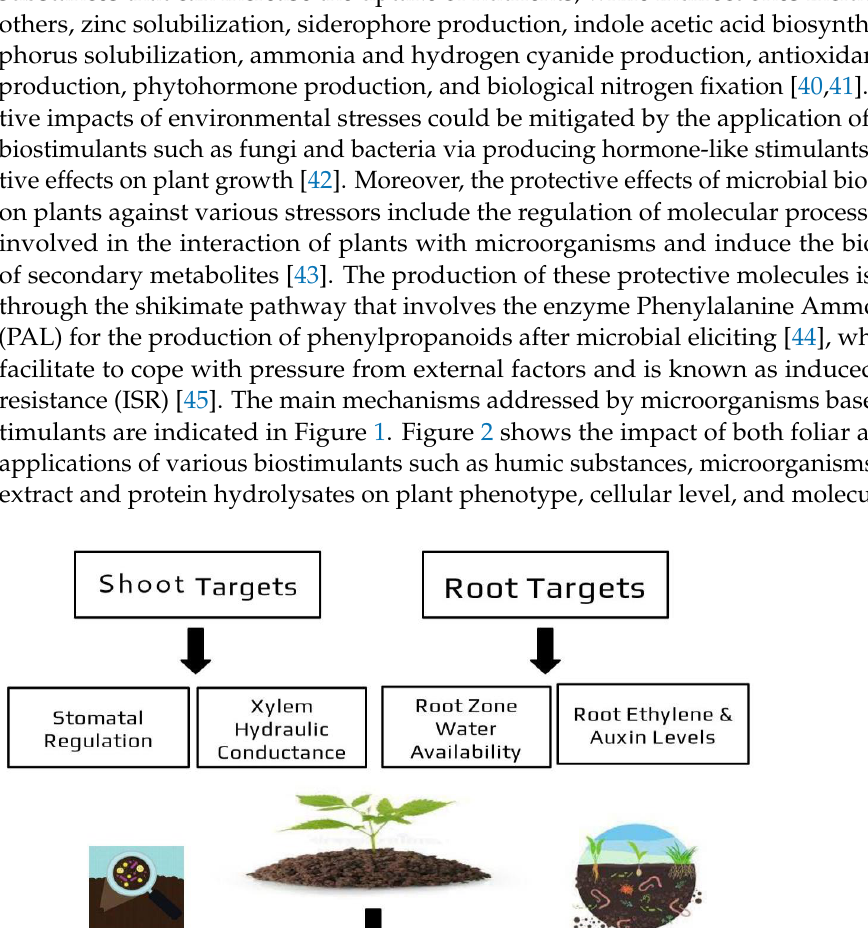
Figure 2. The most notable impacts of different biostimulants on plant phenotype, cellular level and molecular level. 2.1. Modes of Action of Plant Growth-Promoting Rhizobacteria Modes of action of plant growth-promoting rhizobacteria (PGPR) involve the induc- tion of synthesis of biosurfactants and chelating factors, avermectins, secondary metaboli- ties, fluorescent insecticidal toxins, beta-glucanases, and chitinases for disease resistance. Additionally, they may promote antioxidant activity and biosynthesis of phytochemicals, modulate the metabolism, synthesis and accumulation of anthocyanins, polyphenols and vitamin C, which finally results in quality improvement in the crop products. Other